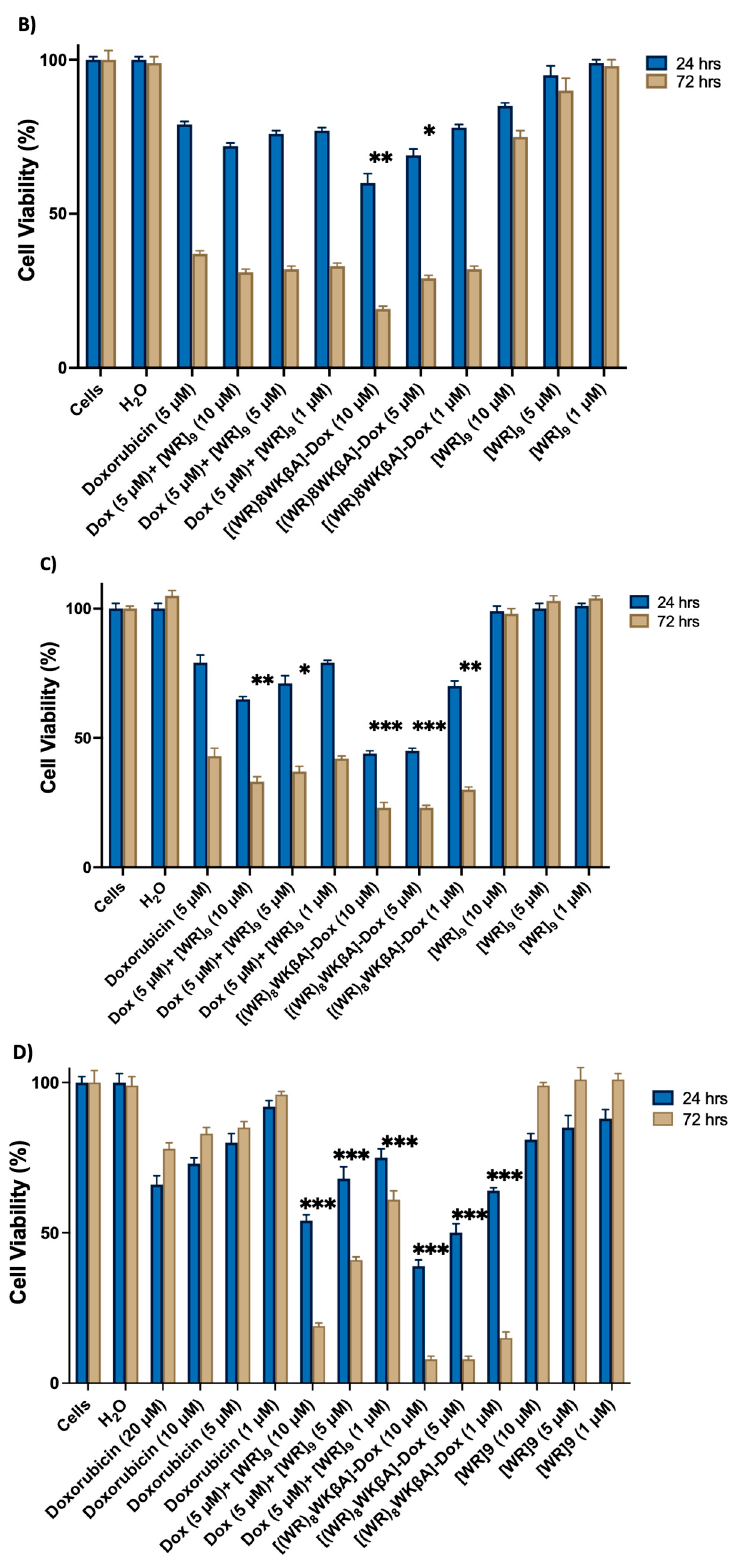
Figure 1. Inhibition of ( A ) SK-OV-3, ( B ) MDA-MB-231, ( C ) MCF-7, and ( D ) MES-SA/MX2 cells (Dox-resistant cells) by free Dox (5 µM) or (1, 5, 10, and 20 µM), [(WR) 8 WKbA]-Dox, [WR] 9 + Dox, and [WR] 9 at 1, 5, and 10 mM. Results are mean ± SD ( n = 3) (* p < 0.05, ** p < 0.01, *** p < 0.001 treatment vs. Ctrl (Dox), p -value only for treatment after 72 h).